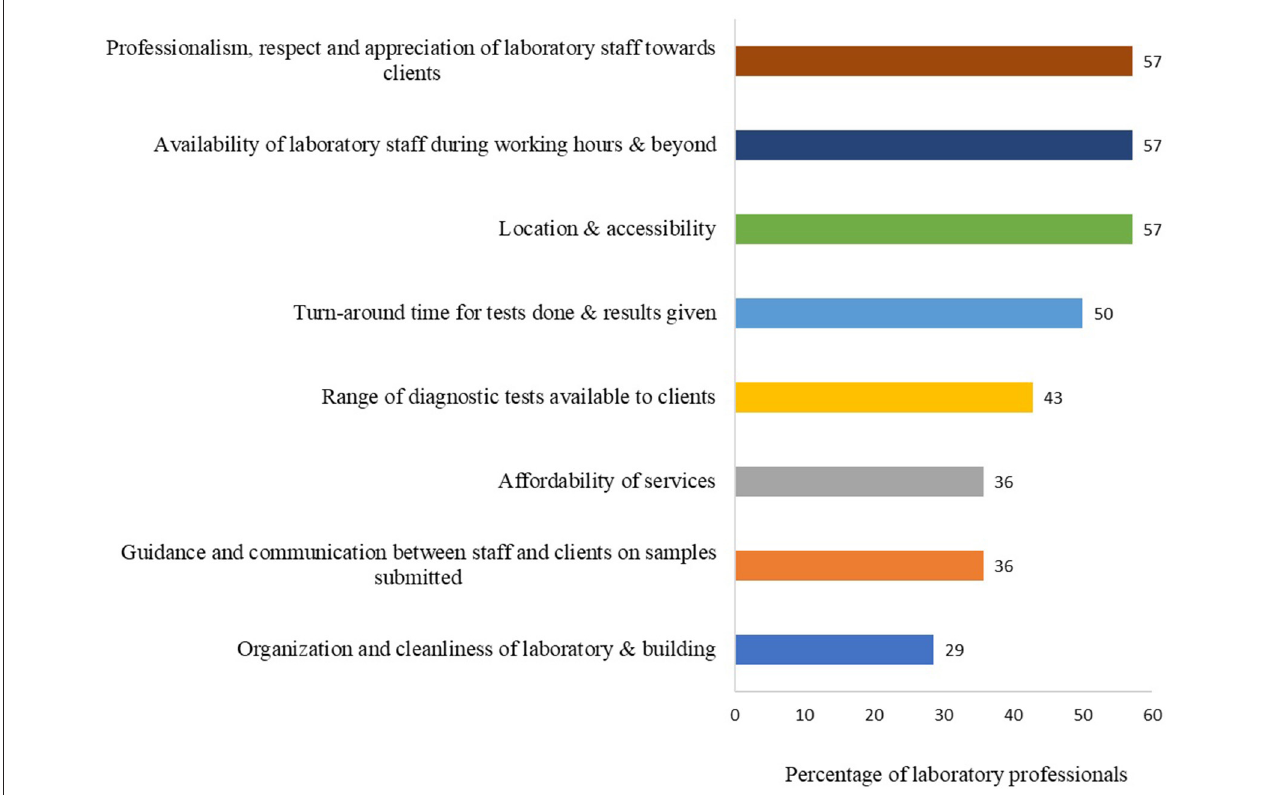
FIGURE 6 | The top five important factors that determine whether clients will submit samples to the laboratory. Bars represent percent of laboratory technicians ( n = 14) that selected each factor. This question had multiple